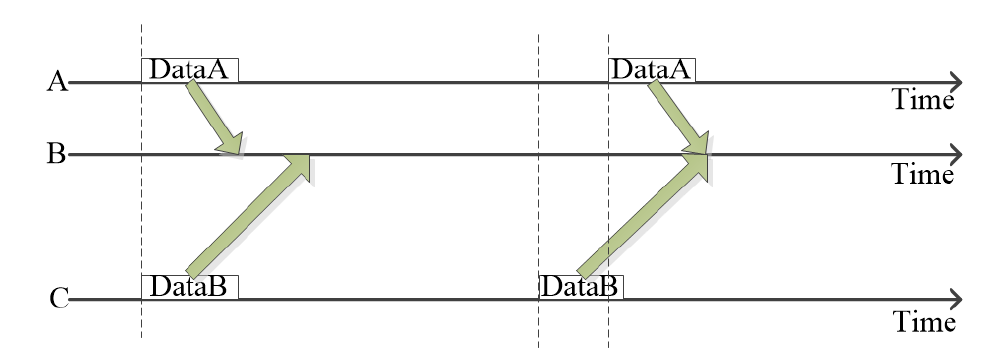
Figure 1. Spatial–temporal